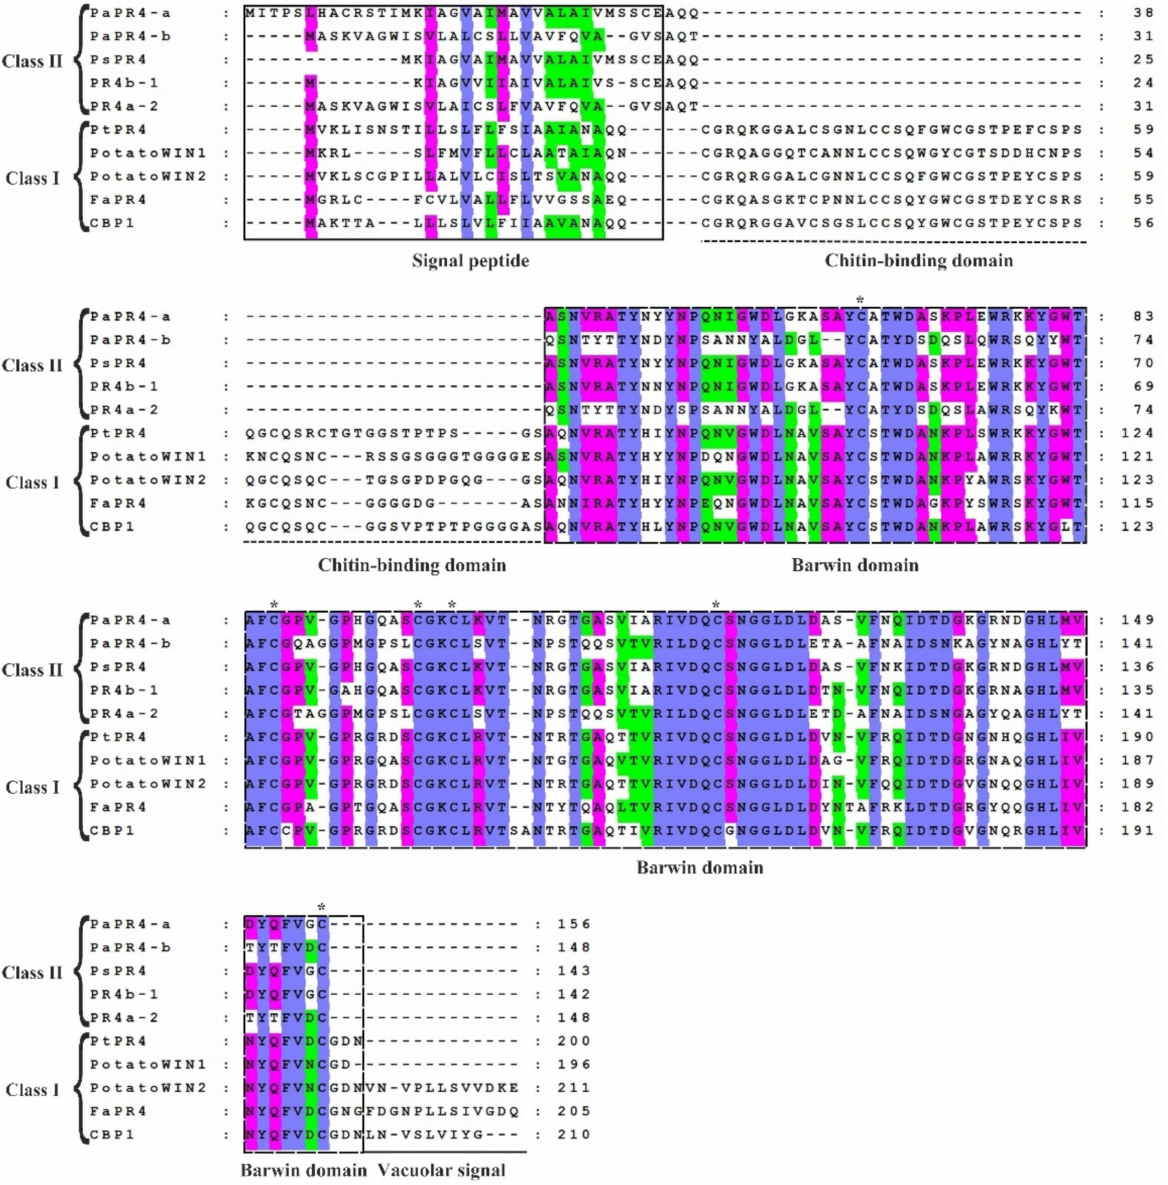
within the Barwin domain are indicated by asterisks